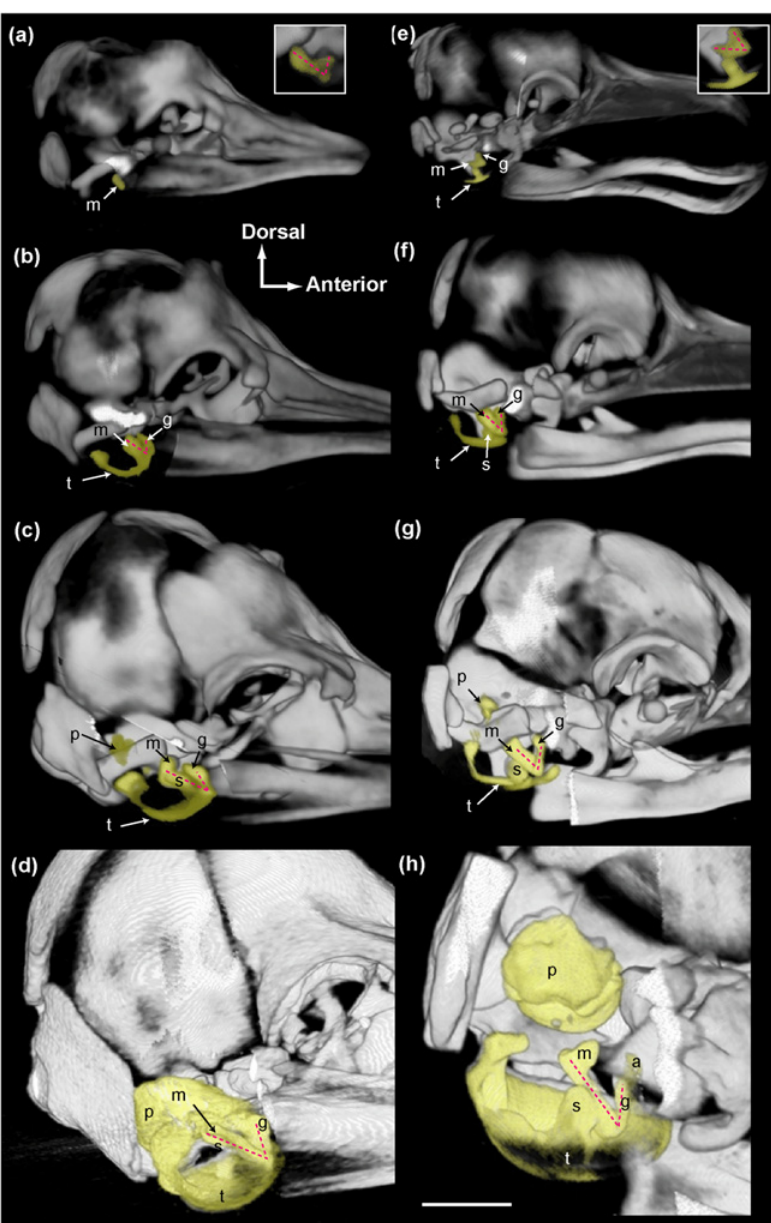
Fig 2. Three-dimensional CT reconstructions illustrating the ontogenetic development of the ears in cetaceans. The tympanoperiotic complex is highlighted in yellow and the right lateral view is shown. Some parts of the skull were digitally removed to expose the ears. The scale bar represents 1 cm for S . attenuata (a- d) and 2 cm for B . physalus (e-h) except for the enlarged inserts in (a) and (e), which are twice the size of the corresponding image. The insert in (a) is a flipped image of the left side, in which the goniale is more distinct compared to the right side. Specimens featured in each panel are as follows: a) USNM 504373; b) USNM 504022; c) USNM 504052; d) USNM 504008; e) USNM 301532; f) USNM 267672; g) USNM 268884; h) USNM 260585. Abbreviations: a, accessory ossicle; g, goniale; m, malleus; p, periotic; s, sigmoid process; t, tympanic. The V-shaped malleus-goniale complex is illustrated by the pink dashed line.